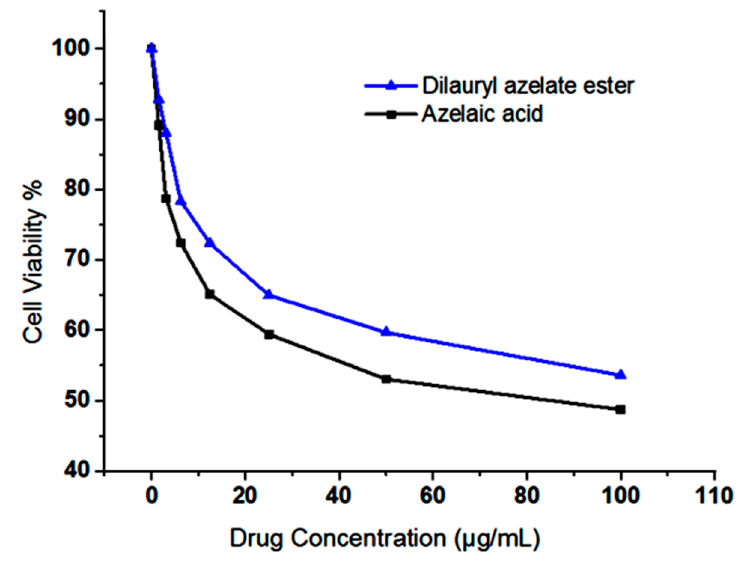
Figure 6. Comparison the toxicity effect of azelaic acid (AzA) and AzA derivatives (dilaurylazelate ester) on normal fibroblasts cell line (3T3). Data represented in percentage (%) of cell viability (IC 50 ).